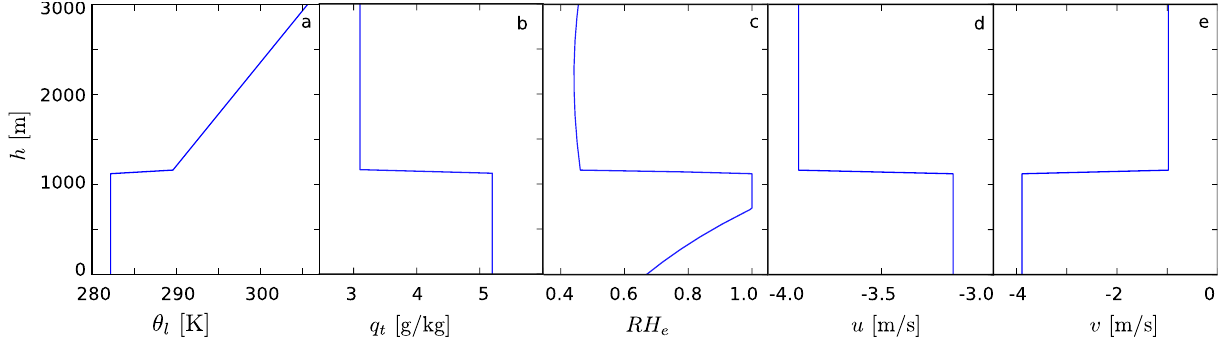
Fig. 5. Idealized profiles of observed mean conditions used to initialize the simulation. (a) Liquid water potential temperature θ l ; (b) total cloud water mixing ratio q t ; (c) relative humidity RH e ; (d) zonal wind u ; (e) meridional wind v